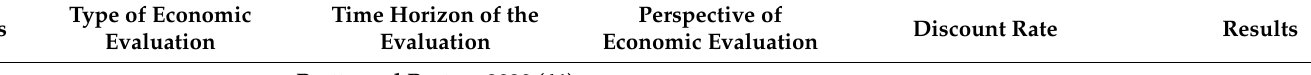
Table 3. Data extraction of the Economic